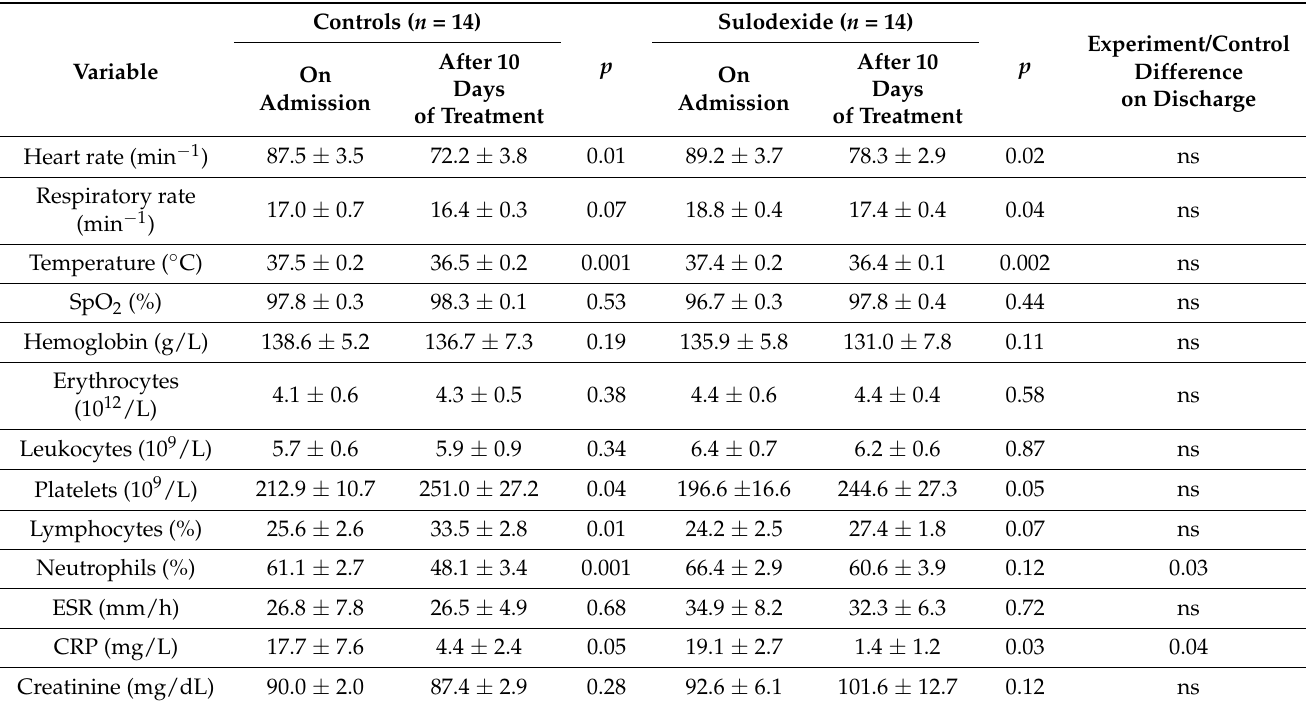
Table 2. Basic biochemical and physiological parameters of COVID-19 patients before and after